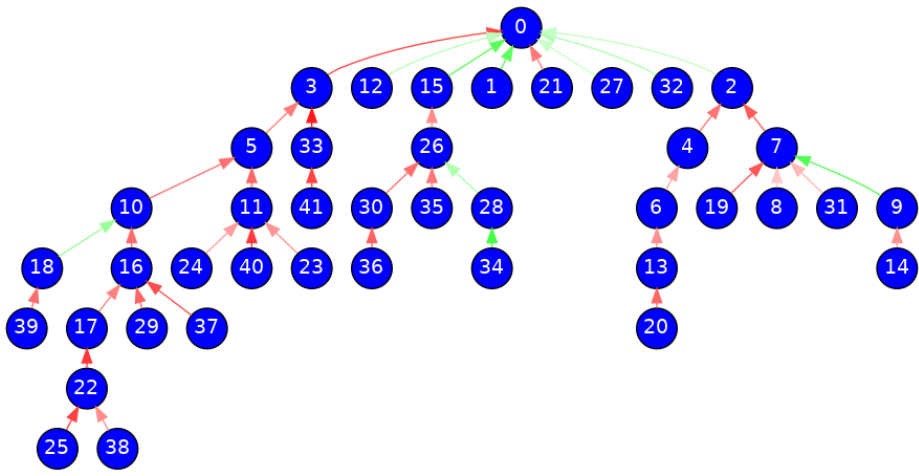
Figure 1. Debate tree for a Reddit debate of the subreddit World